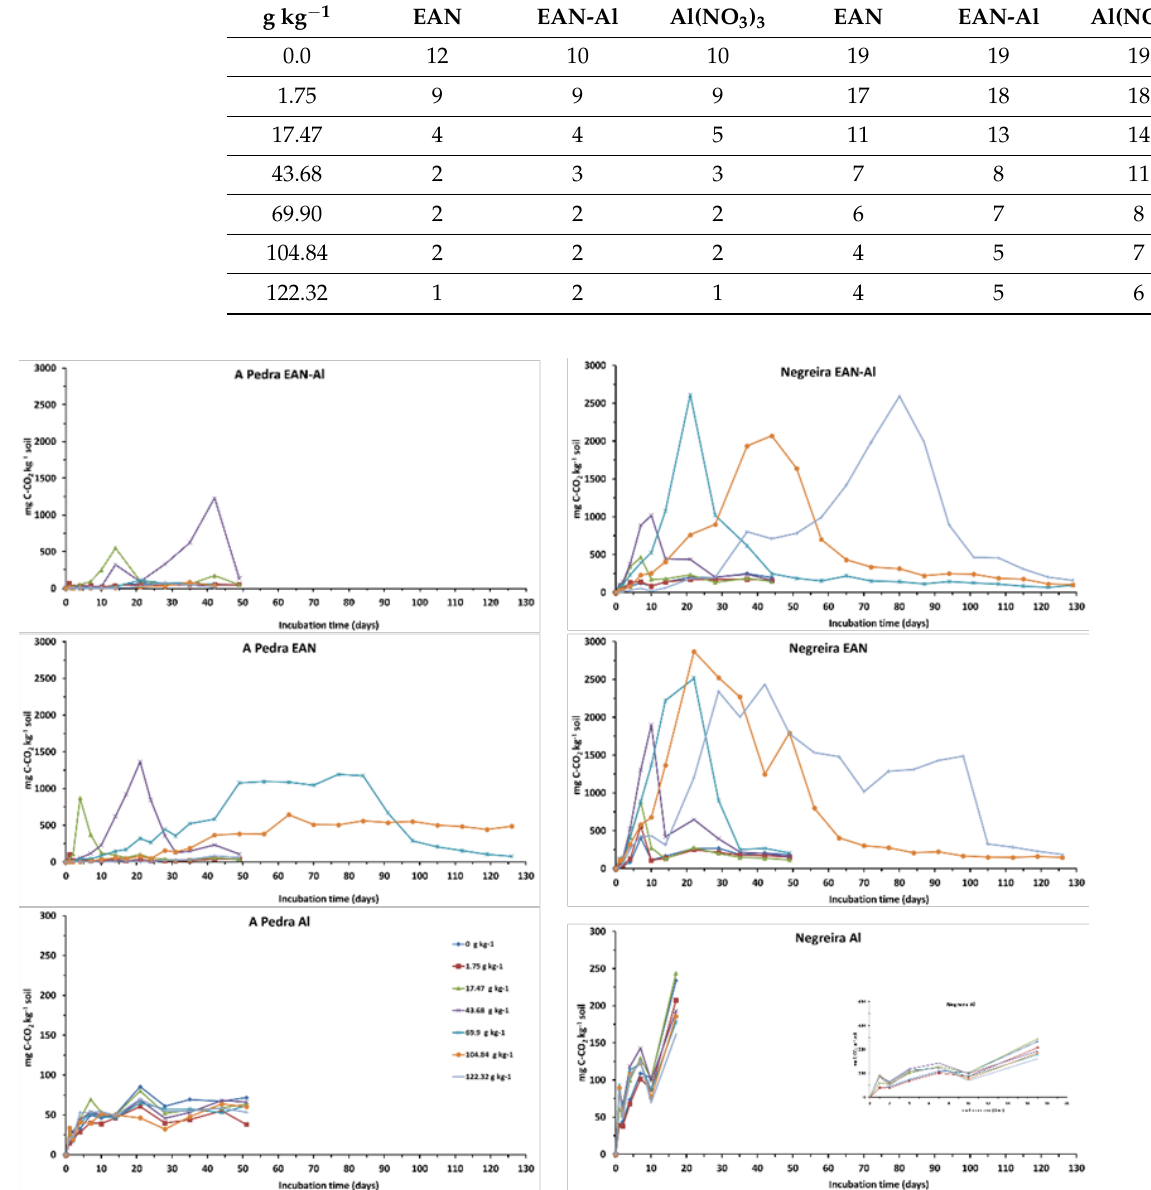
Table 4. C/N ratios in A Pedra and Negreira soils spiked with different doses of ethylammonium ni- trate (EAN), ethylammonium nitrate plus aluminium salt (EAN-Al), or aluminium nitrate (Al(NO 3 ) 3 ) . Dose C/N Ratio A Pedra Soil